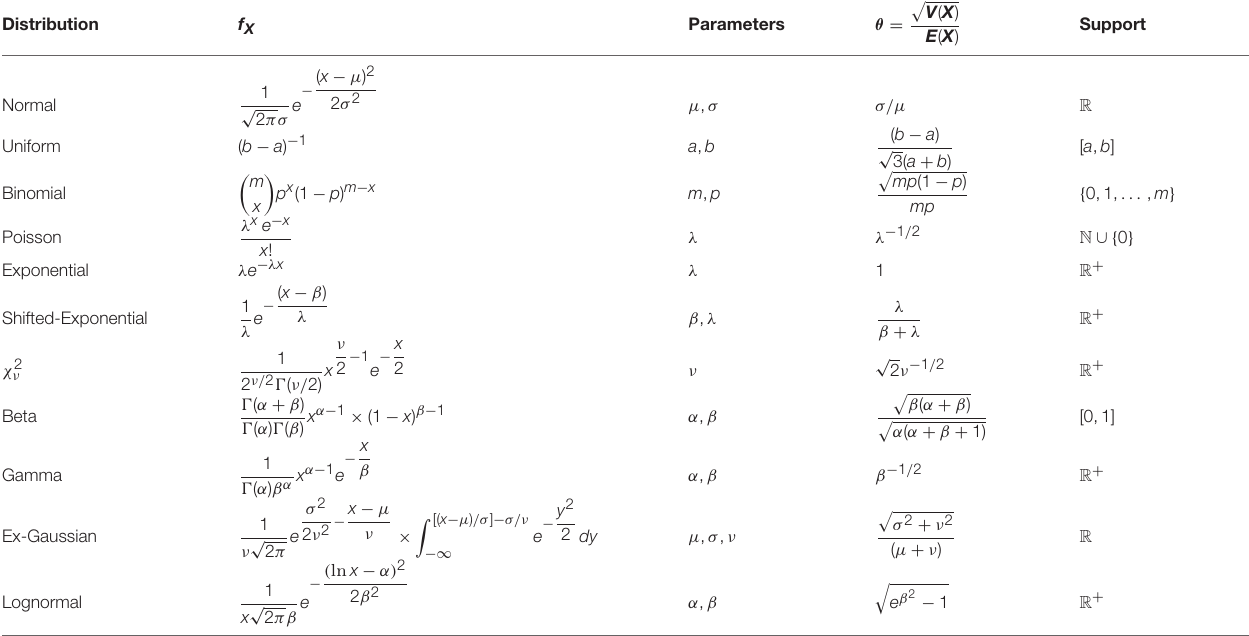
TABLE 2 | Probability parametric distributions considered in this study.